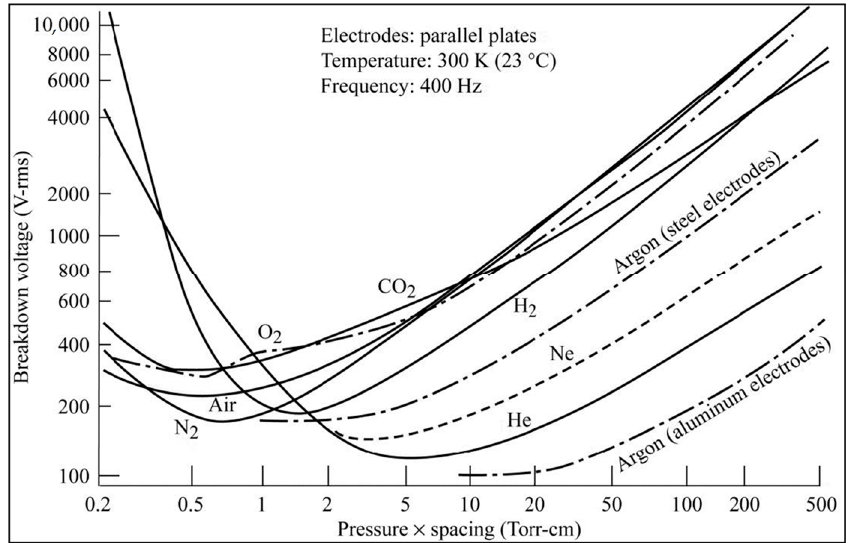
Figure 1. Dielectric breakdown Paschen curves for various gases at room temeprature and 400 Hz.